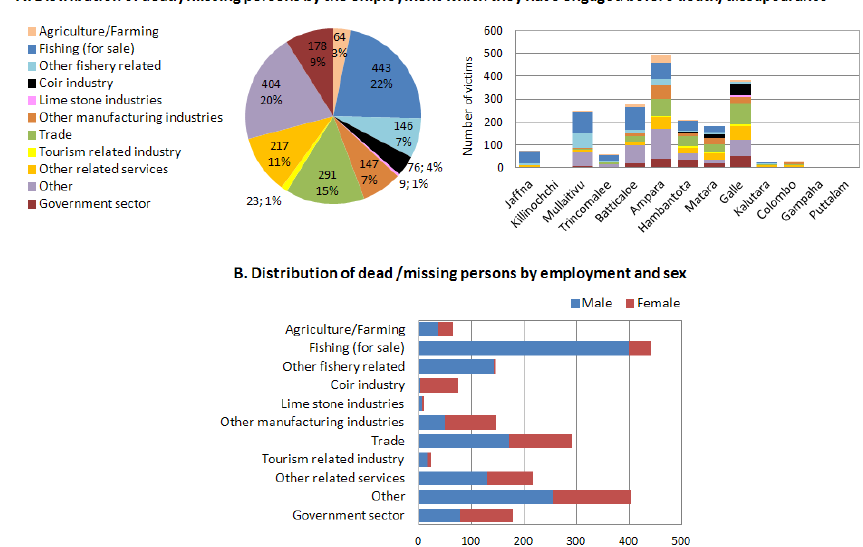
Figure 15. Distribution of tsunami victims by employment and district (Sri Lanka tsunami 2004). Panel (a) shows distribution of dead/missing persons by the employment they were engaged in before death/disappearance; panel (b) shows distribution of dead/missing persons by employment and